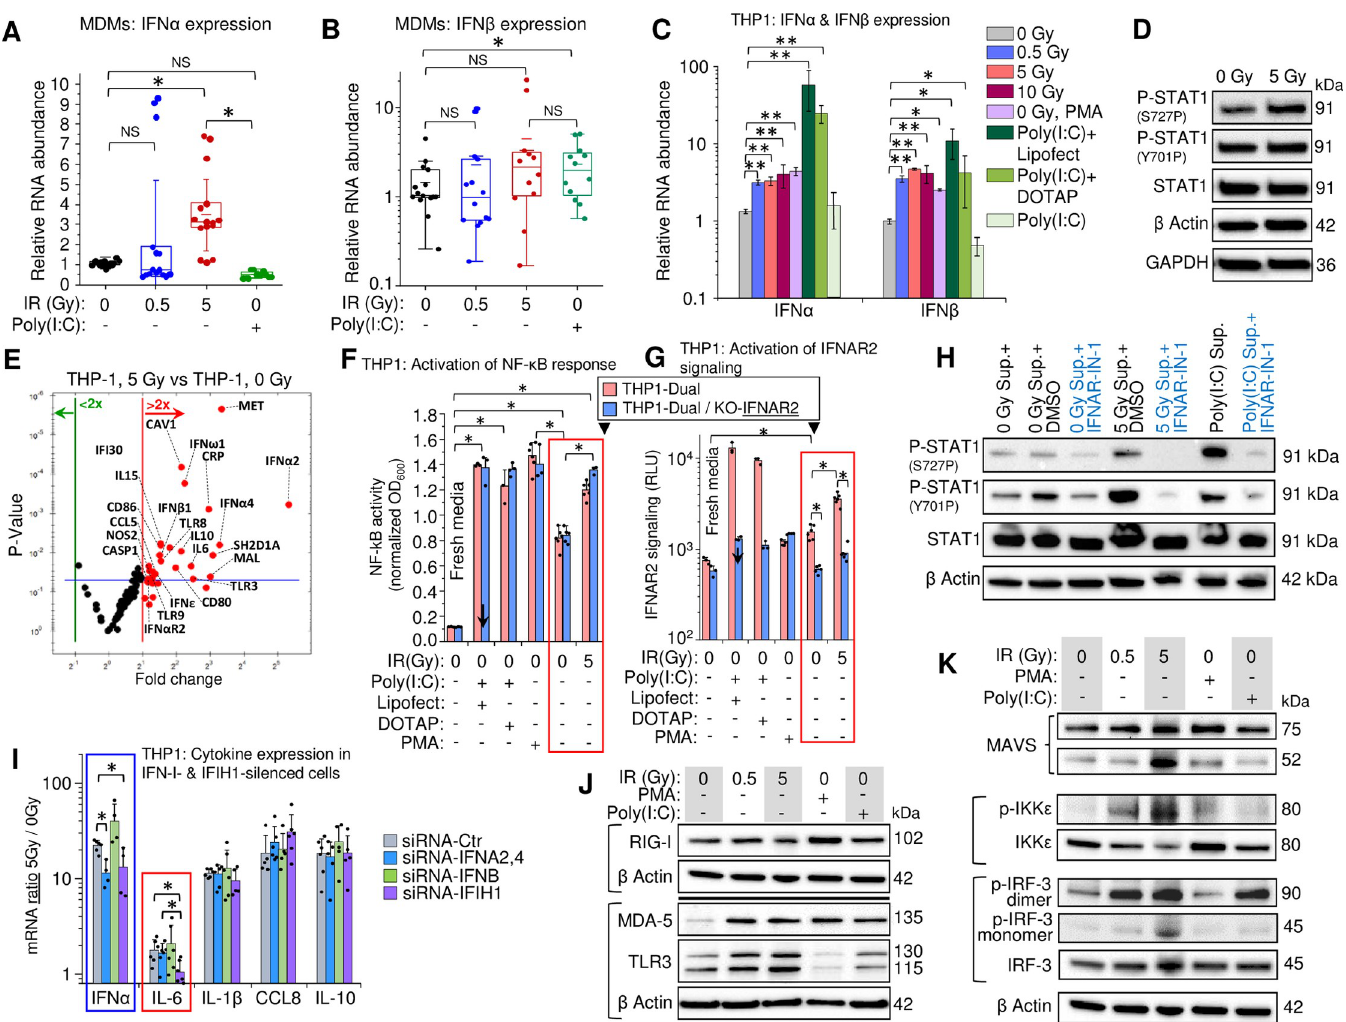
Fig 3. Gamma radiation induces expression of type I interferons and inflammation-related genes in THP1 monocytes and MDMs. ( A and B ) Box plots showing expression, measured by RT-qPCR, of IFN α ( A ) and IFN β ( B ) in MDMs, 48h after irradiation (n = 15). M-CSF-differentiated MDMs from PBMCs isolated from 5 donors were exposed to indicated doses of γ IR. Error bars: ± SD, � p < 0.05, NS non-significant, paired Wilcoxon test. ( C ) Expression of IFN α and IFN β in THP1 cells, 48h post-irradiation, measured by RT-qPCR. Cells were exposed to indicated doses of γ IR or treated with PMA or poly(I:C) with or without indicated transfection reagents. Error bars: ± SD of four independent biological replicates; � p < 0.05, �� p < 0.01. ( D ) Immunoblotting of phosphorylated STAT1 at Ser727 and Tyr701 (40 μ g of total protein) in THP1 cells, 48h post-irradiation. ( E ) Volcano plot showing ISG expression in irradiated vs. control THP1 cells, measured by PCR array of total cellular RNA samples, 48h post-irradiation. Red dots indicate significant (above blue line) or insignificant (below blue line) increase in gene expression in irradiated cells ( p < 0.05, fold change > 2.0). ( F and G ) Activation of NF- κ B-dependent transcription ( F ) and IFNAR signaling ( G ) by culture media from irradiated (5 Gy) or non-irradiated THP1 in the reporter THP1-Dual cells (pink columns) expressing SEAP gene driven by an IFN- β minimal promoter activated by NF- κ B and secreted Lucia luciferase gene under the control of an IFNAR signaling-activated ISG54 minimal promoter, and THP1-Dual KO-IFNAR2 cells (blue columns), generated from THP1-Dual cells by stable knockout of the IFNAR2 receptor. Similarly, the culture supernatant from Poly(I:C)-transfected THP1 was used as a positive control. After 18 h of incubation and staining with SEAP-sensitive QUANTI-Luc dye, the absorbance (600 nm) (F) or luminescence (G) of each sample were measured and normalized to fresh RPMI media controls. Error bars indicate ± SD of a minimum of 3 independent biological replicates; p < 0.01. ( H ) Immunoblotting to assess STAT1 Ser727 and Tyr701 phosphorylation (20 μ g of total protein) in THP1 cells incubated for 24h with filtered culture media from irradiated or non-irradiated THP1, with or without interferon- α / β receptor inhibitor IFNAR-IN-1. ( I ) Expression ratio of IFN α and indicated cytokines (5 Gy-to-0 Gy ratio of RNA count) in THP1 cells transfected with indicated siRNA (24 h before irradiation), with or without exposure to 5 Gy γ IR for 48 hours. RNA was quantified by RT-qPCR. Error bars: ± SD of at least four independent biological replicates; � p < 0.05. ( J ) Immunoblot of ssRNA sensor RIG-I and dsRNA sensors MDA-5 and TLR3 (40 μ g of total protein) in THP1 cells, 48h post-irradiation. ( K ) Western blot of downstream markers of the activation of RIG-I/MDA-5 (MAVS, phospho-IKK ε , and phospho-IRF3) and TLR3 (phospho-IKK ε , and phospho-IRF3) pathways. THP1 lysates (40 μ g total protein), harvested 48h post-exposure.